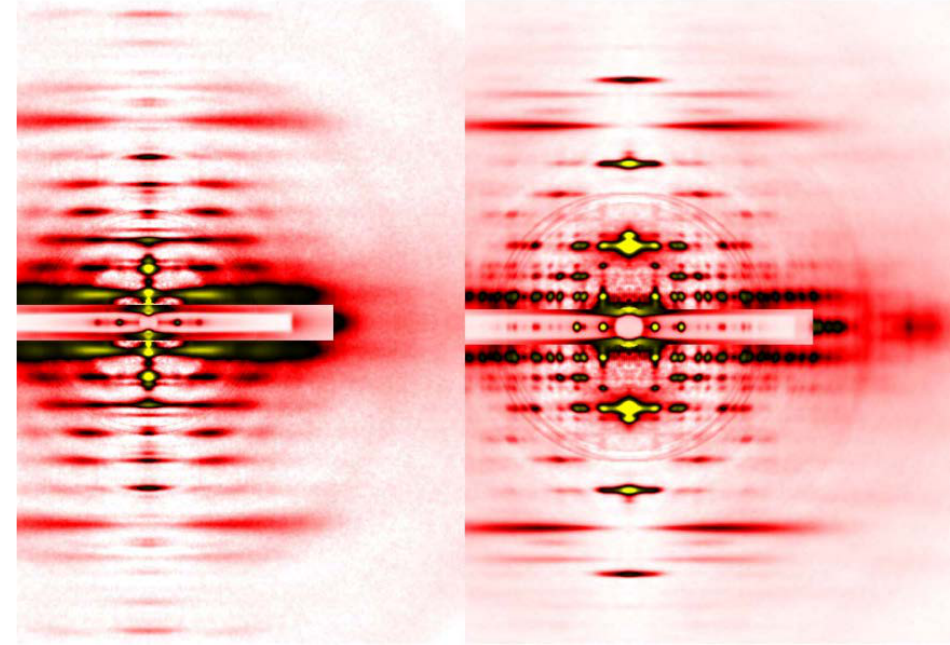
Figure 4. Comparison of diffraction patterns from vertebrate skeletal muscle fibers ( left , identical to